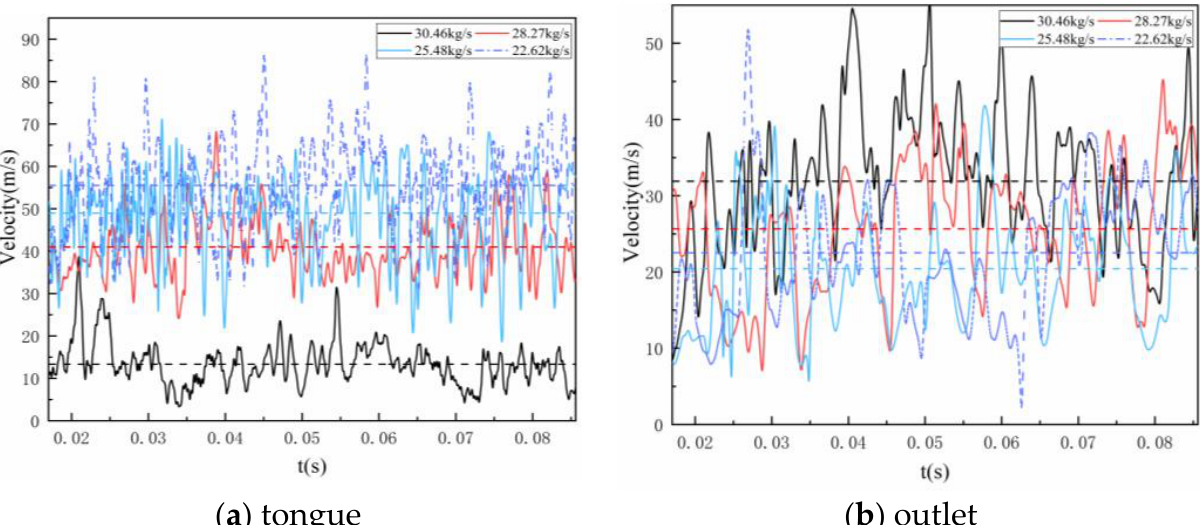
Figure 15. Velocity fluctuation at monitoring points of tongue and outlet and four different mass- flow cases.